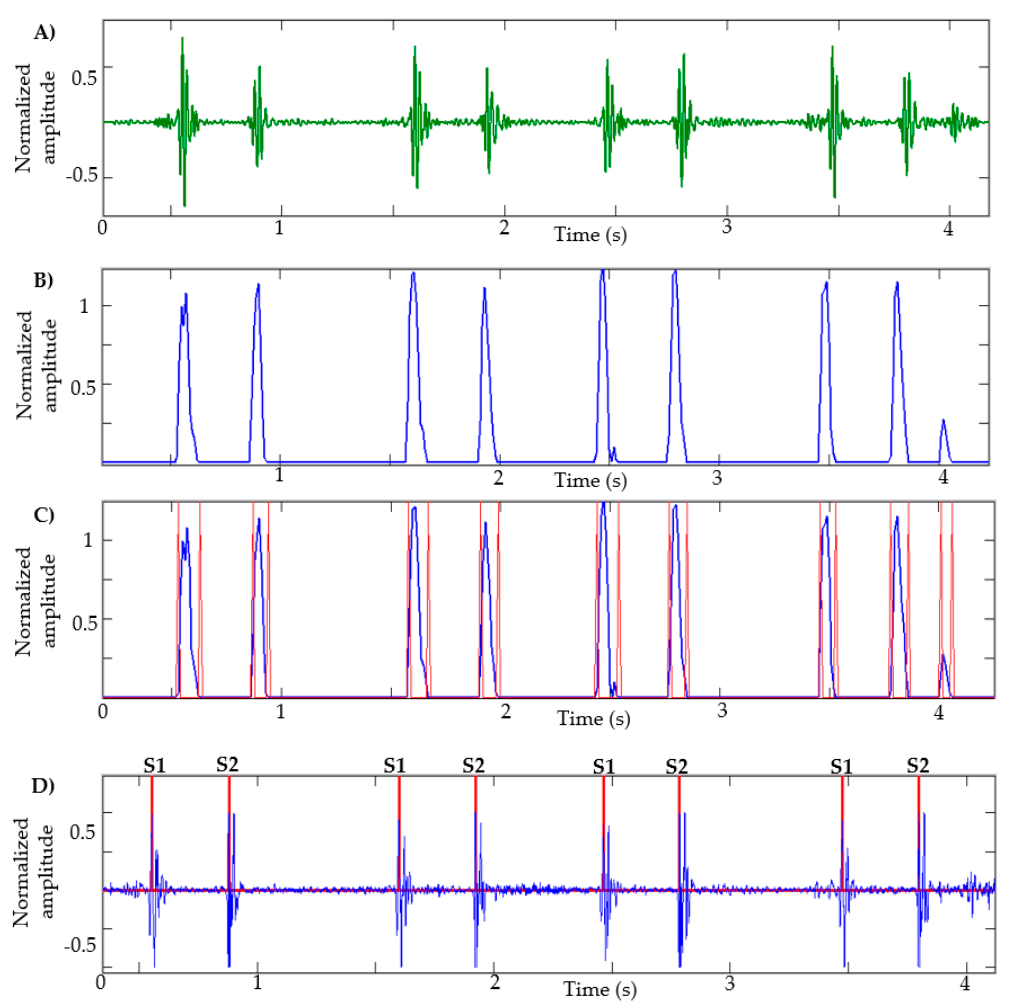
Figure 3. Stages of segmentation: a) EWT component: heart sound; b) NASE of the signal; c) identification of borders of each lobe; d) identification of S1 and S2 sounds.